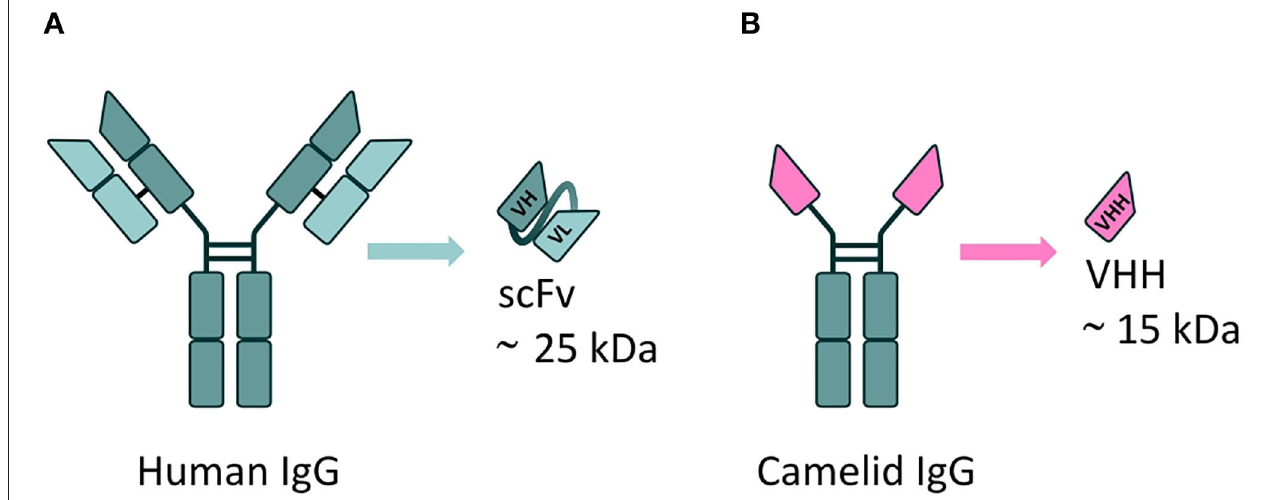
FIGURE 5 | mAbs derivatives for A-MAD. (A) Representative scheme of a single-chain fragment variable (scFv) antibody fragment, derived from a human immunoglobulin. This class of engineered antibody is composed of the variable regions of the heavy (VH) and light chains (VL) fused by a linker. Their applicability is limited by potential folding and stability issues in the reducing environment of the cell. (B) Representative scheme of a VHH, the smallest antigen-binding functional fragment in nature, derived from a camelid immunoglobulin. The small size, high antigen specificity and exceptional stability of VHH (including in the reducing environment of the cell) make them an ideal cargo for rAAV vector-mediated delivery to target CNS